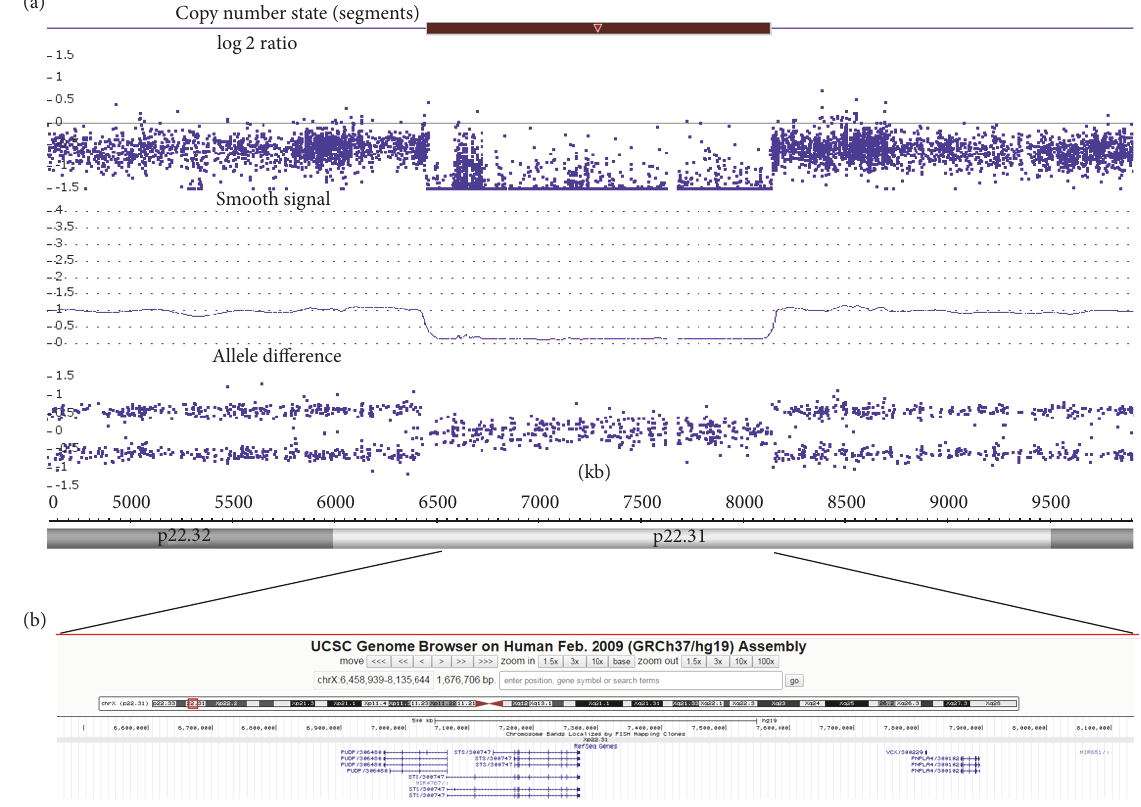
Figure 2: (a) Affymetrix CytoScan chromosomal microarray analysis detected a 1.7 Mb deletion at Xp22.31 (6,458,939–8,135,644, genome build hg 19) in our male patient. (b) UCSC genome browser image showing the Xp22.31 deletion. The deleted interval contains six known genes (PUDP, STS, MIR4767, VCX, PNPLA4, and MIR651).